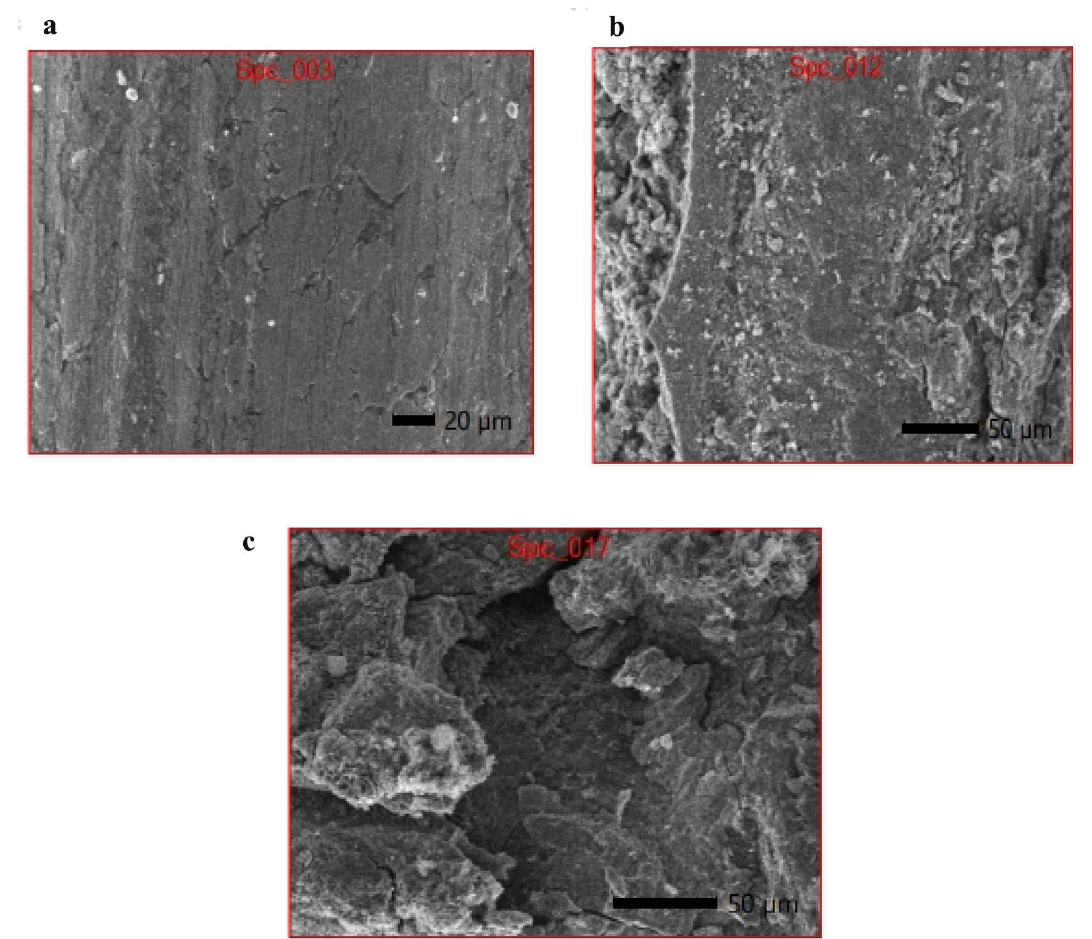
Fig. 13 SEM of electrodes’ surface: a before dyes removal and b after RR49 removal, c after RY15 removal